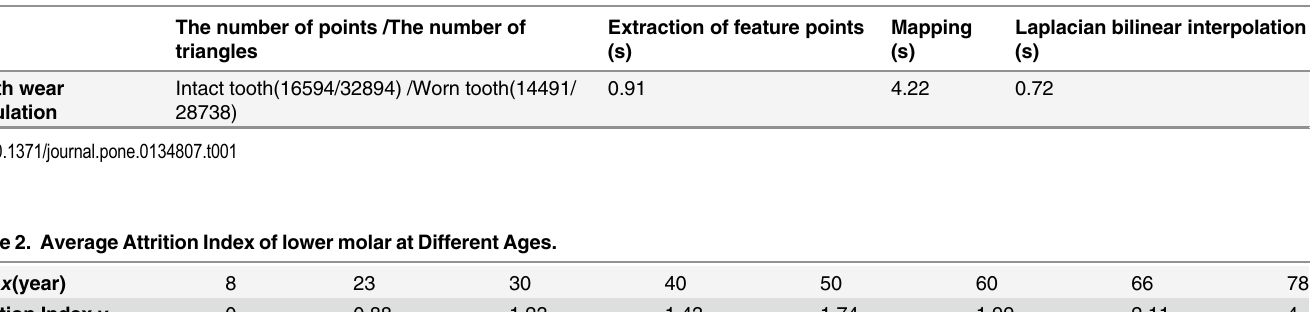
Table 1. Simulation time of tooth wear.